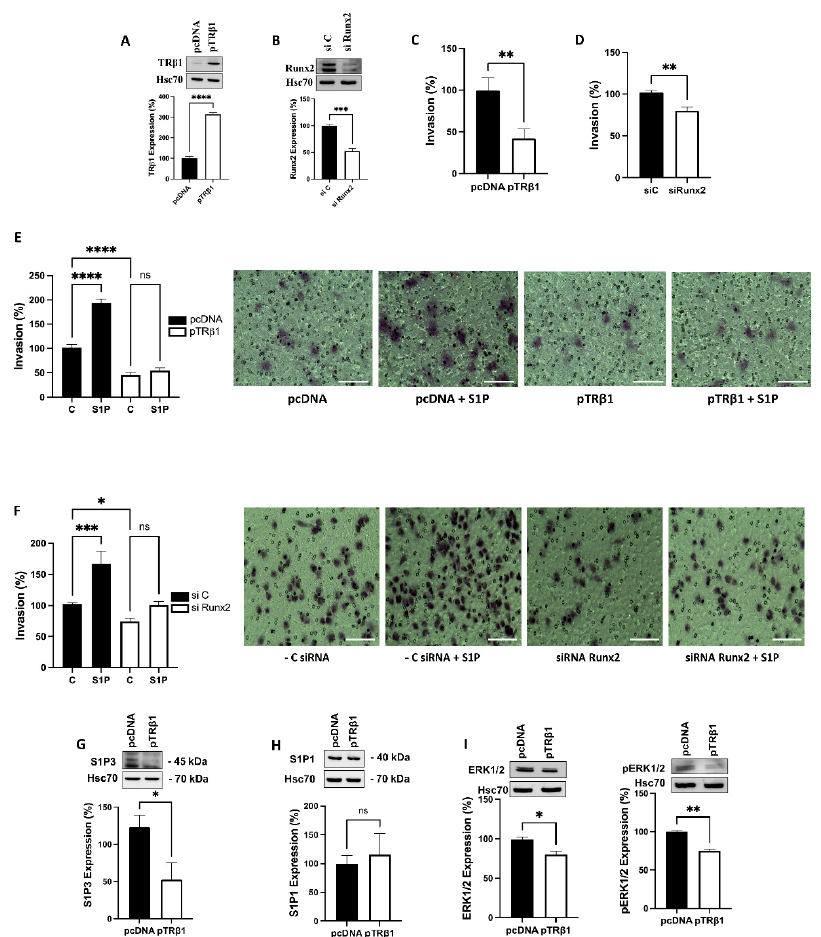
Figure 5. TR β 1 and Runx2 regulate basal and S1P-evoked invasion of thyroid cancer ML-1-cells. ( A ), A representative western blot showing the transfection efficacy of TR β 1 plasmid. Hsc70 was used as a loading control. The bar diagram shows the mean ± SEM ( n = 3). **** p < 0.0001. ( B ), A representative western blot showing the transfection efficacy of siRunx2. Hsc70 was used as a loading control. The bar diagram shows the mean ± SEM ( n = 3). *** p < 0.001. ( C ), Overexpression of TR β 1 (pTR β 1) decreased the invasion of ML-1 cells compared to control transfected cells (pcDNA). The bar diagram shows the mean ± SEM ( n = 3). ** p < 0.01. ( D ), Runx2 knockdown decreased the invasion of ML-1 cells. The bar diagram shows the mean ± SEM ( n = 3). ** p < 0.01. ( E ), Overexpression of TR β 1 attenuated basal and abolished S1P-evoked invasion in ML-1 cells. The bar diagram shows the mean ± SEM ( n = 3). ns = not significant, **** p < 0.0001. The representative images of invasion inserts are shown. The scale bar is 100 µ m. ( F ), Runx2 knockdown attenuated basal and S1P-evoked invasion in ML-1 cells. The bar diagram shows the mean ± SEM ( n = 3). ns = not significant, * p < 0.05, *** p < 0.001. The representative images of invasion inserts are shown. The scale bar is 100 µ m. ( G ), Overexpression of TR β 1 decreased the protein expression of S1P3 in ML-1 cells. A representative Western blot is shown. Hsc70 was used as a loading control. The bar diagram shows the mean ± SEM ( n = 3). * p < 0.05. ( H ), Overexpression of TR β 1 had no effect on the protein expression of S1P1 in ML-1 cells. A representative Western blot is shown. Hsc70 was used as a loading control. The bar diagram shows the mean ± SEM ( n = 3). ns = not significant. ( I ), Representative western blots showing the expression of ERK1/2 and pERK1/in TR β 1 overexpressing cells Hsc70 was used as a loading control. The bar diagram shows the mean ± SEM ( n = 3). * p < 0.05, ** p < 0.01. 3.8. Overexpression of TR β 1, but Not Runx2, Restored Thyroid Specific Protein Expression Thyroid specific proteins, such as thyroperoxidase (TPO), thyroglobulin (TG), and sodium/iodide symporter (NIS), have been shown to be downregulated in